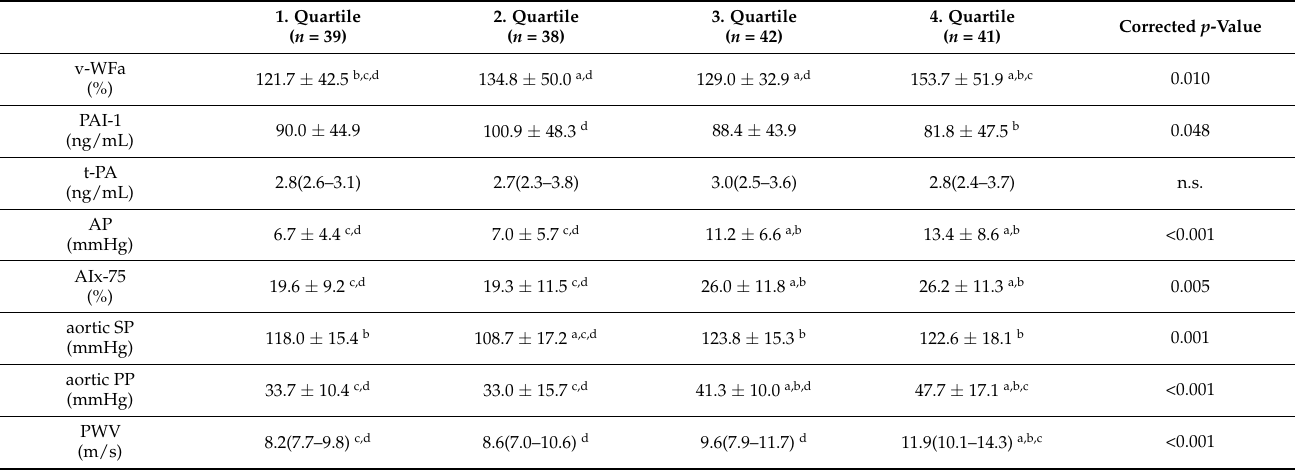
Table 2. Vascular damage parameters in individual quartiles according to age.